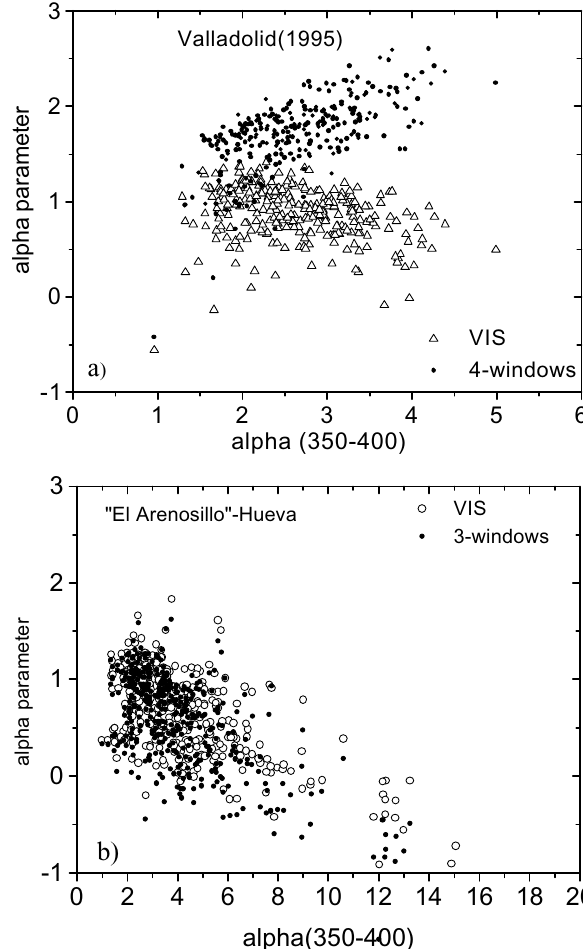
Fig. 4. Plot of the α parameter determined in the VIS and “window range” range versus the values determined in the (350–400nm) UV range” a for the data of the north central station of Valladolid; b for the data of the southwest station of “El